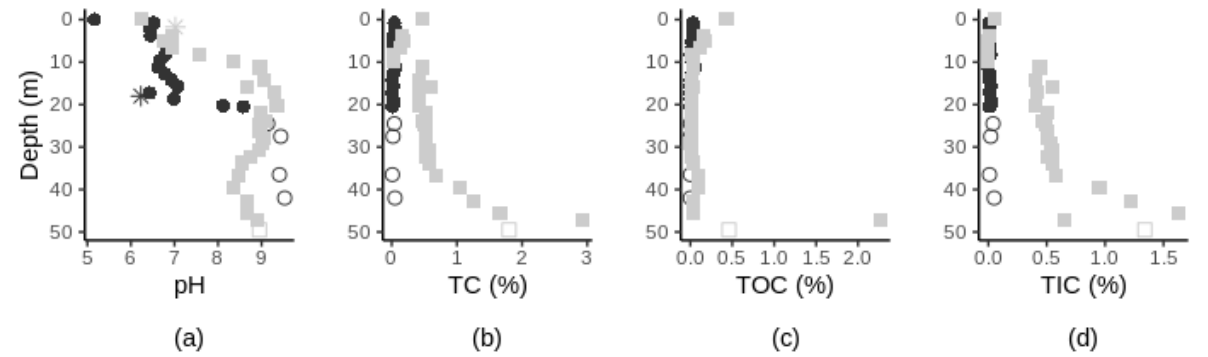
Figure 3. Chemical characteristics of geological material along depth at site 1 (black circles) and site 2 (grey squares) with pH ( a ), TC ( b ), TOC ( c ) and TIC ( d ) along depth. Surface sample at site 1 was removed from the TC, TOC and TIC figures for a better visual representation. Bedrock samples are represented by hollow symbols. pH of the groundwater samples (located at 18 m and 1.75 m of depth, at site 1 and 2 respectively) are indicated by stars in ( a ). For full details on the changes of soil characteristics, see Supplementary Tables S1 and S2.